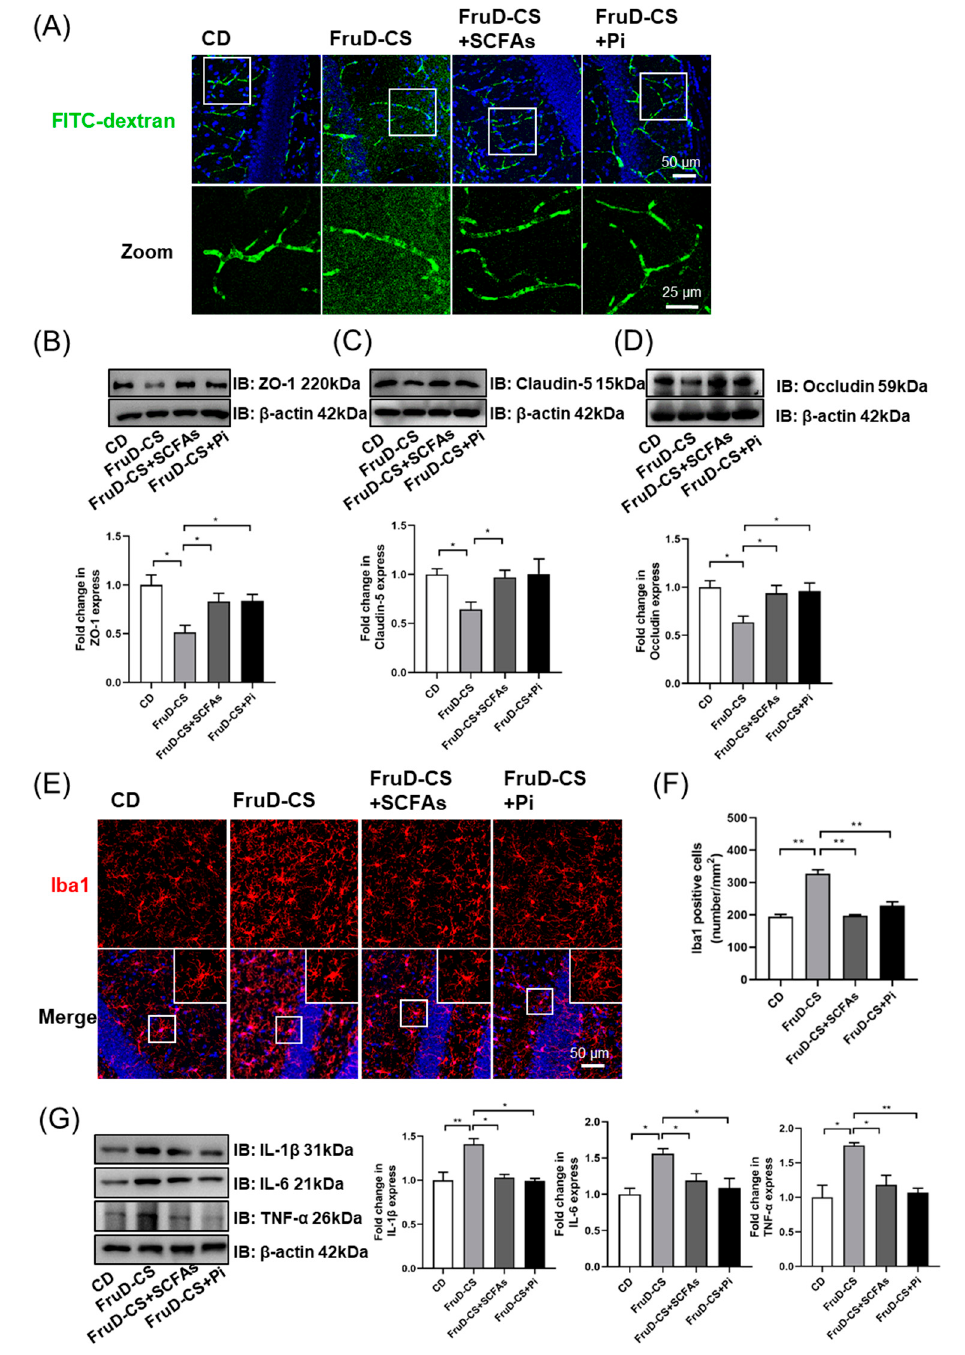
Figure 6. SCFAs and pioglitazone repaired BBB damage in FruD-CS mice. ( A ) Representative confocal images for brain vessel visualization in mice injected of FITC-dextran. ( B – D ) Representative immunoblot and quantification of ZO-1 ( B ), claudin-5 ( C ) and occludin ( D ) protein levels in brain vessel. ( E ) Representative confocal images labeled with Iba1. ( F ) Number of Iba1 positive microglia was quantified. ( G ) Representative immunoblot and quantification of IL-1 β , IL-6 and TNF- α protein levels in the hippocampus. Data are expressed as mean ± SEM, * p < 0.05, ** p < 0.01.